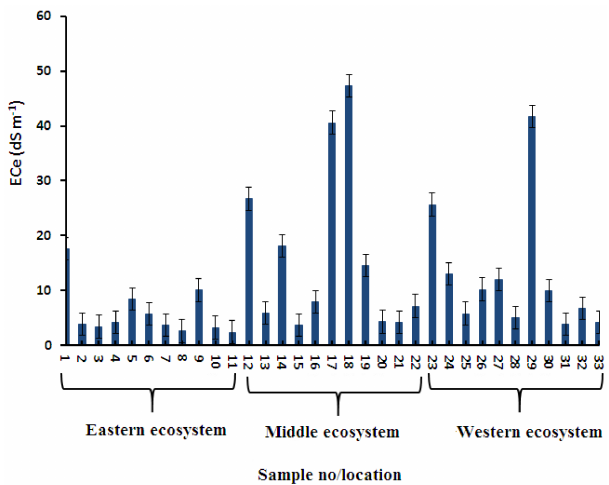
Figure 10. Salinity of selected soil samples ( n =